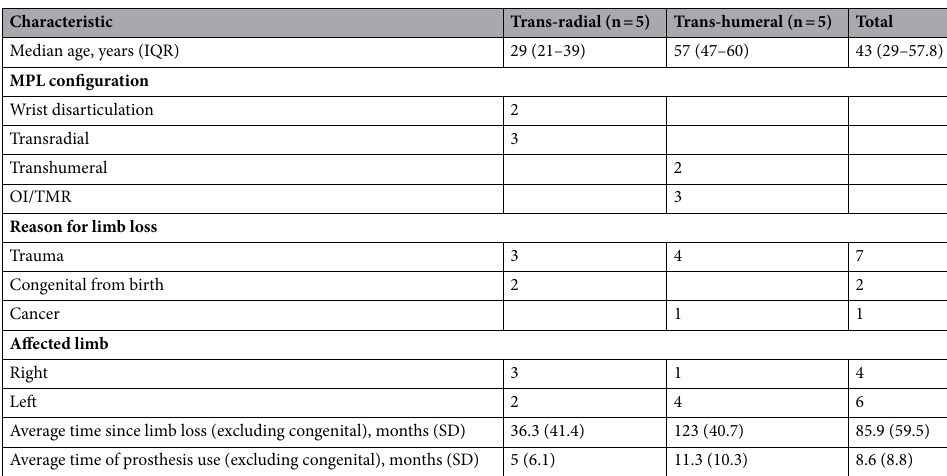
Table 1. Participant demographic and clinical characteristics. Study participant demographic and clinical characteristics. Of 21 consented research participants, 11 completed all study sessions and 10 were included in final data analysis. Participants with congenital limb absence were excluded from analyses of average time since limb loss and of prosthetic